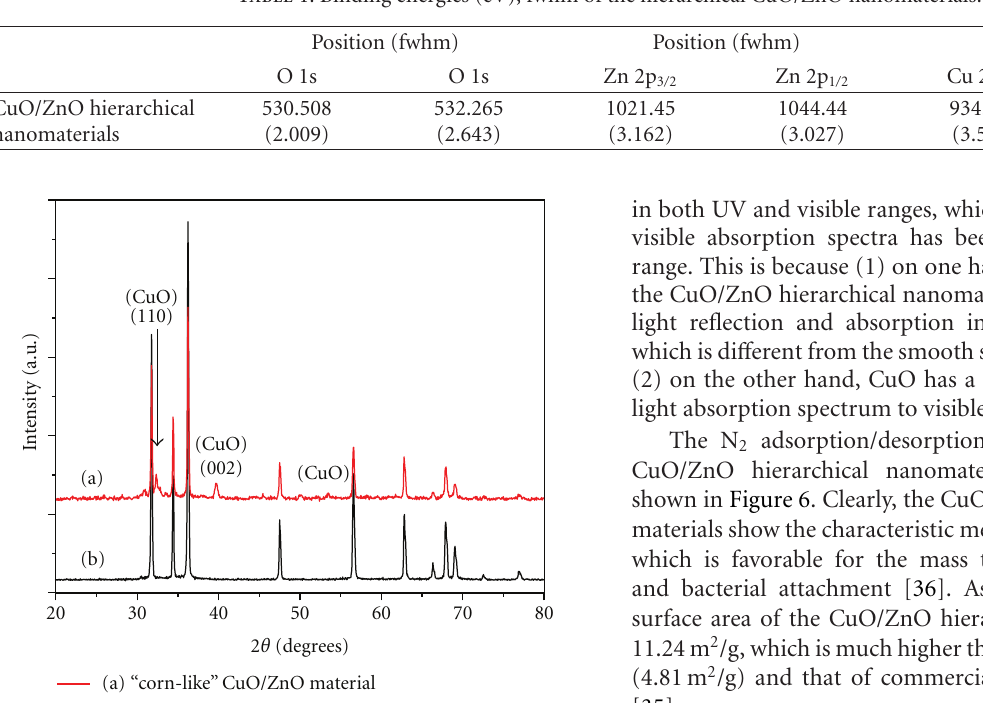
Table 1: Binding energies (eV), fwhm of the hierarchical CuO/ZnO nanomaterials.